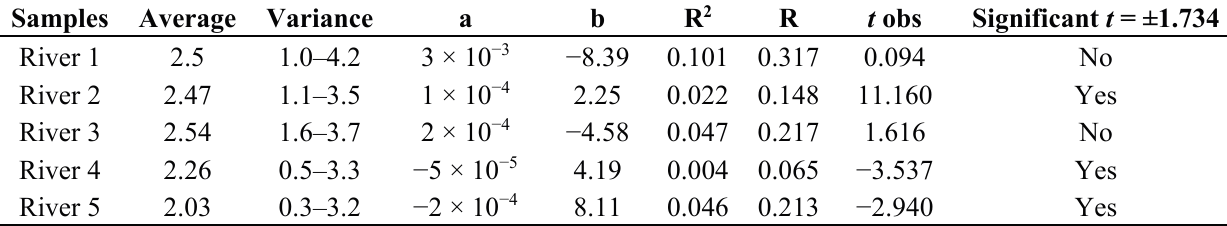
Table 3. Average and variance of fecal bacterial concentrations (log 10 cfu/100 mL) in only dry weather river samples 1 to 5 with linear regression analysis (Y = ax + b) and result of null hypothesis based on t -distribution (20 samples analyzed for each river sampling spot).